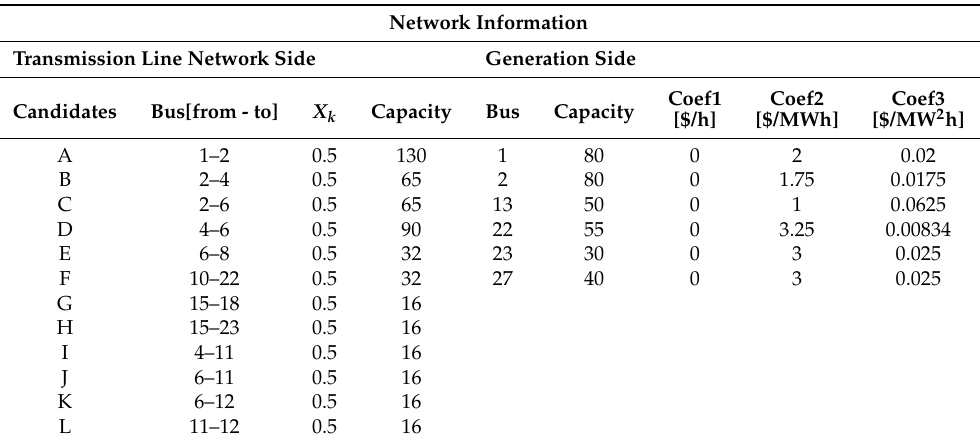
Figure 3. IEEE 30-bus system, red and blue dotted lines are expected candidates for new construction. Table 2. Parameters for candidate lines and